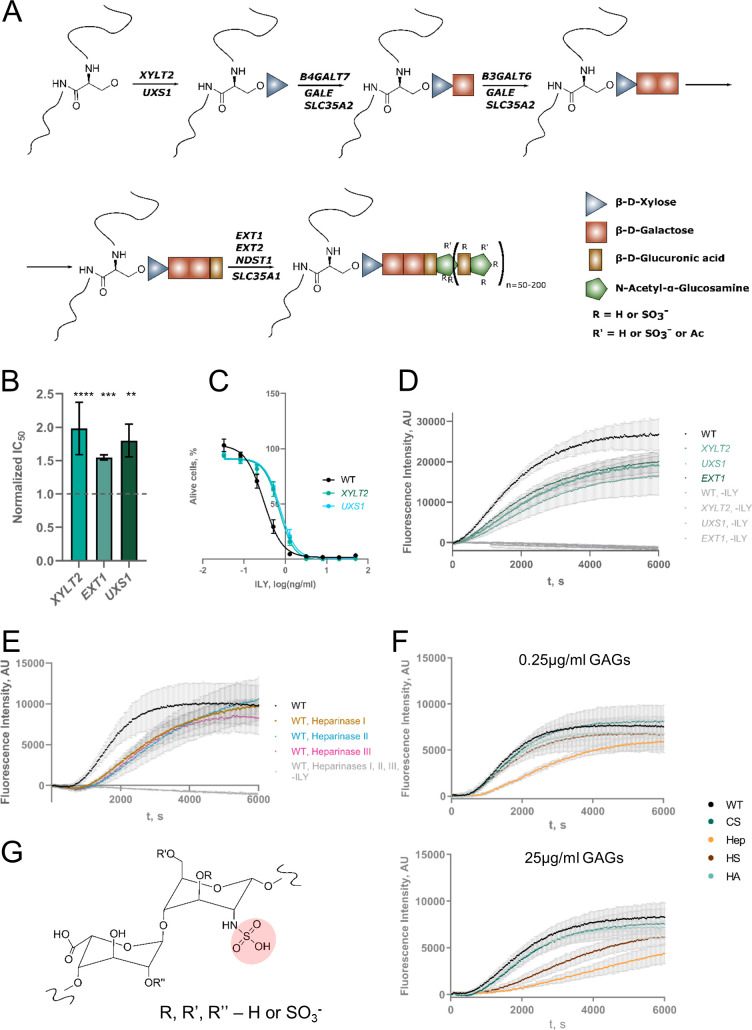
Heparan sulfate knock-out inhibits the action of ILY.A. Schematic representation of heparan sulfate synthesis. Genes listed on the arrows were identified in this study. B. Resistance conferred by the knock-out of select heparan sulfate pathway genes. Values were normalized by dividing the raw IC50 value by the IC50 value of ILY in WT HAP-1 cells. The dashed line shows the WT IC50 value. n = 3, error bars represent standard deviations. p-values were calculated using two-tailed t-test; *–<0.05; **–<0.01, ***–<0.001; ****–<0.0001. C. Lysis profiles of cell lines with XYLT2 and UXS1 KOs. n = 3, error bars represent standard deviations. D. Qualitative kinetics of the ILY pore formation on the cells bearing heparan sulfate pathway KOs. Higher fluorescence intensity corresponds to more propidium iodide entering pores formed by ILY and is a surrogate measurement of the speed at which pores form and cells are lysed. n = 3, error bars represent standard deviations. E. Qualitative kinetics of the ILY pore formation on the cells treated with heparinase enzymes. Higher fluorescence intensity corresponds to more propidium iodide entering pores formed by ILY and is a surrogate measurement of the speed at which pores form and cells are lysed. n = 3, error bars represent standard deviation. F. Qualitative kinetics of the ILY pore formation on the WT cells in the presence of different glycosaminoglycans (GAGs). WT–no GAG added; CS–chondroitin sulfate; Hep–heparin; HS–heparan sulfate; HA–hyaluronic acid. Higher fluorescence intensity corresponds to more propidium iodide entering pores formed by ILY and is a surrogate measurement of the speed at which pores form and cells are lysed. Heparin (and heparan sulfate, at higher concentrations) competitively inhibits ILY. n = 3, error bars represent standard deviations. G. Structure of heparin or heparan sulfate repeating disaccharide unit. Out of all GAGs tested, heparin and heparan sulfate are the only GAGs that can be N-sulfonylated at the amine group of the glucuronic acid (although N-sulfate can be substituted by acetyl- moiety). The unique sulfate group is highlighted in pink.